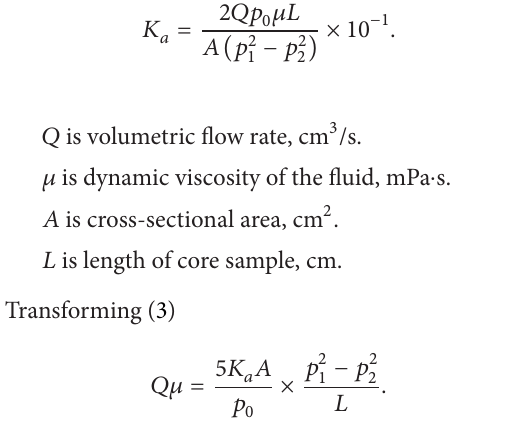
Figure 1: Schematic diagram of the experimental apparatus.